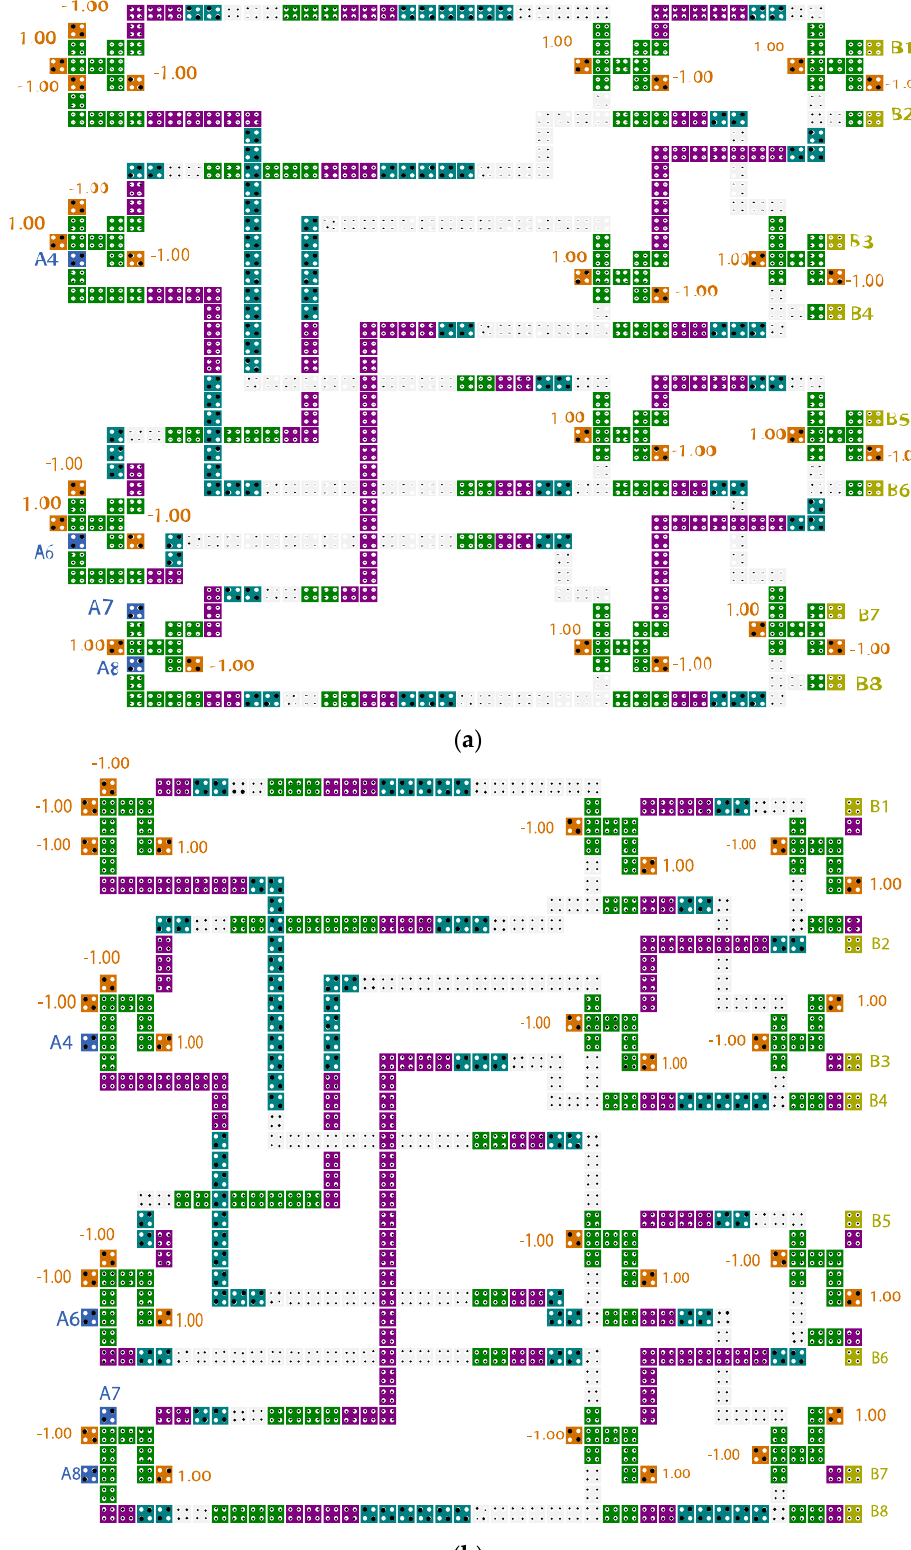
Figure 21. The QCA implementation of the proposed G(8, 4) circuits. ( a ) the first G(8, 4) and ( b ) the second G(8,